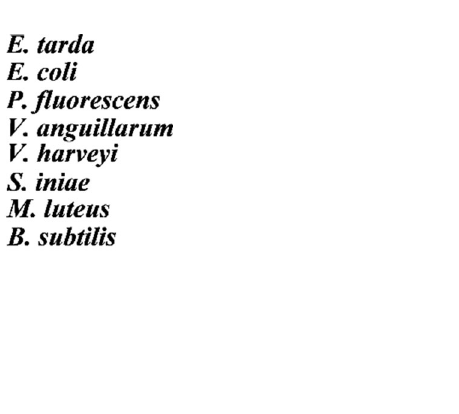
FIGURE 7 | Binding of rPoC3a to bacteria. Edwardsiella tarda, Escherichia coli, Pseudomonas fl uorescens, Vibrio anguillarum, Vibrio harveyi, Streptococcus iniae, Micrococcus luteus and Bacillus subtilis were incubated with or without different concentrations of rPoC3a, and bacteria-protein binding was determined by ELISA. Data are the means of three independent assays and presented as means ±